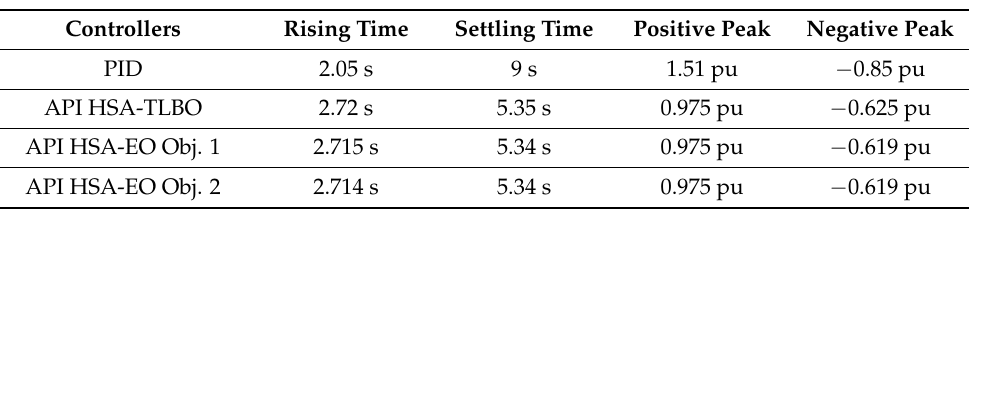
Figure 12. ( a ) Active power responses of normal first case. ( b ) Focusing of the active power response. ( c ) Blade − angle responses of normal first case.